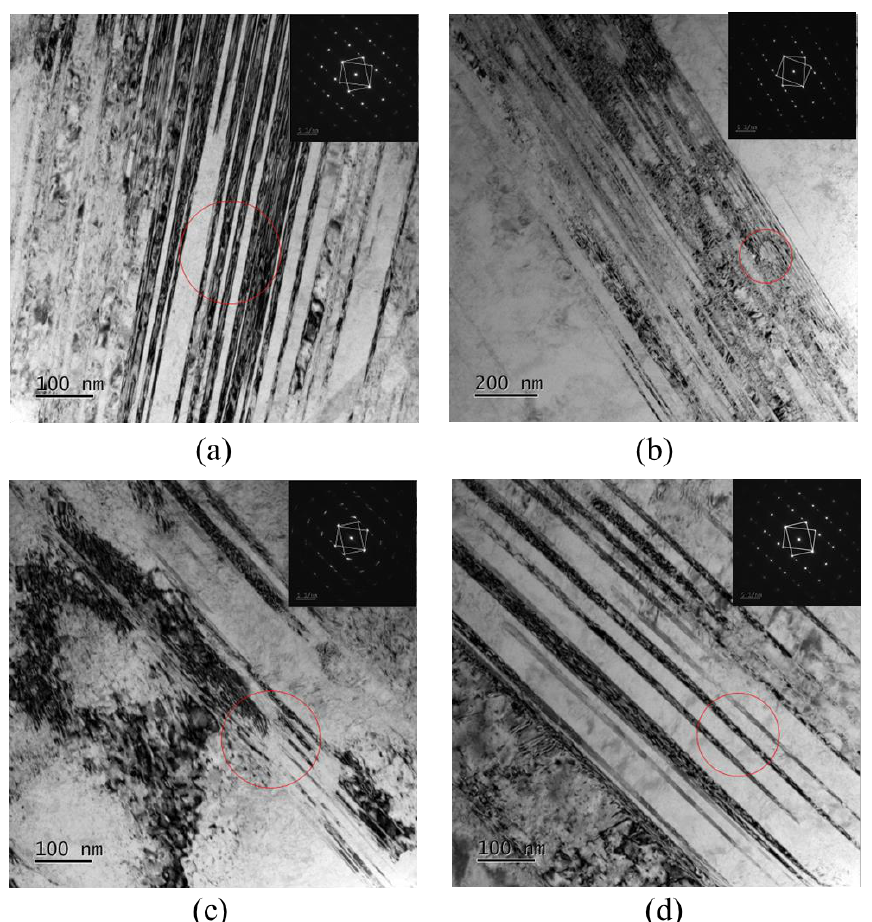
Figure 22. Transmission electron microscope (TEM) bright-field images of LRPs after impact: ( a ) the initial FeNiCoCr HEA LRP, v = 1136 m/s; ( b ) the initial FeNiCoCr HEA LRP, v = 1429 m/s; ( c ) the LRP of FeNiCoCr HEA annealed at 850 ◦ C, v = 1052 m/s; ( d ) the LRP of FeNiCoCr HEA annealed at 1000 ◦ C, v = 1039 m/s.